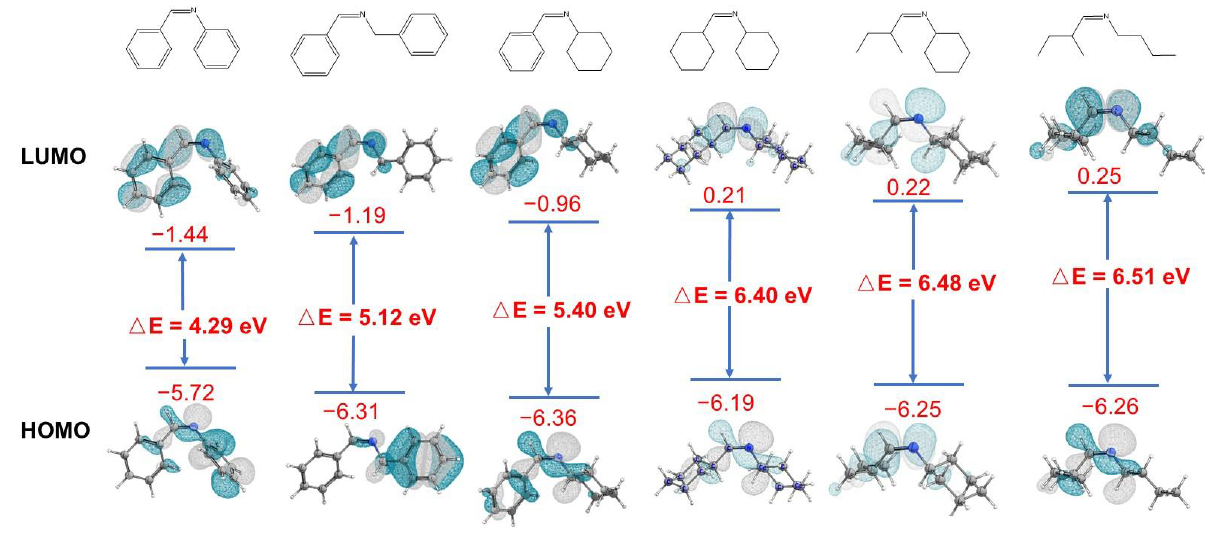
Figure 5. HUMO and LUMO orbitals of different imines in cis -configuration.